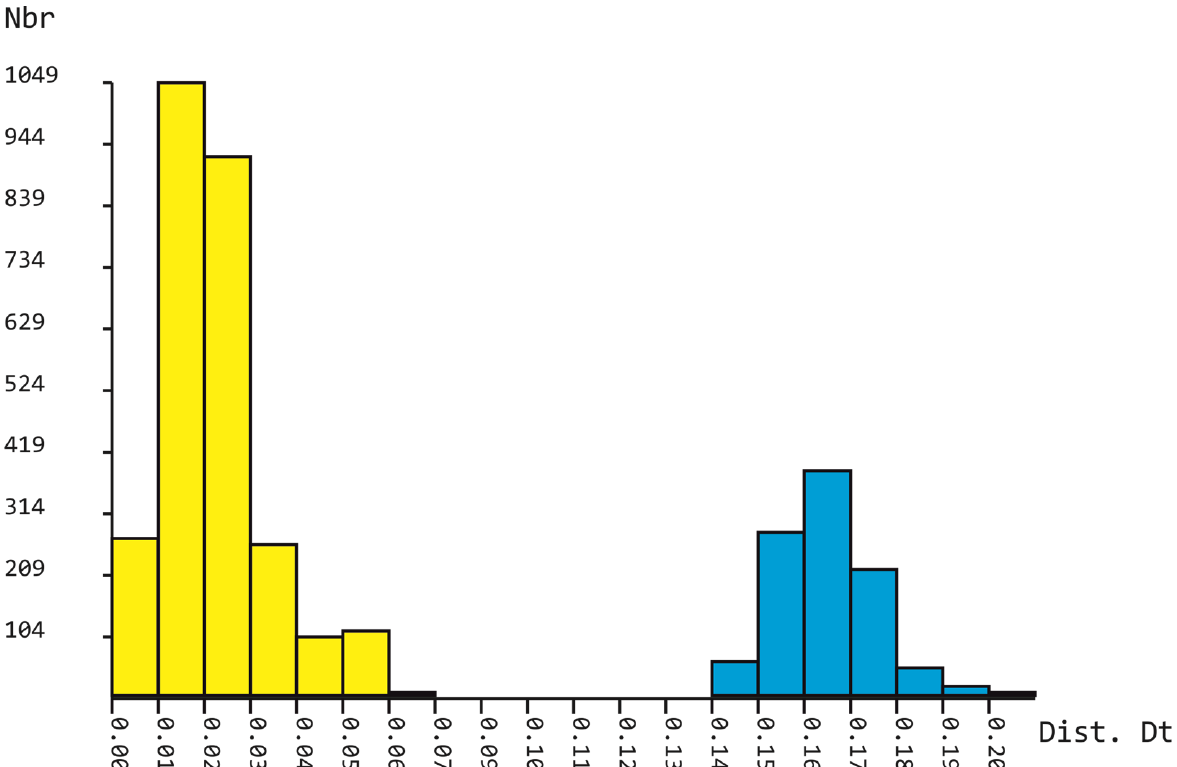
Figure 3. Results of Assemble Species by Automatic Partitioning (ASAP) analysis for trn G-intron sequences. Distribution of pairwise differences. Dt.—distance value; Nbr—number of runs.